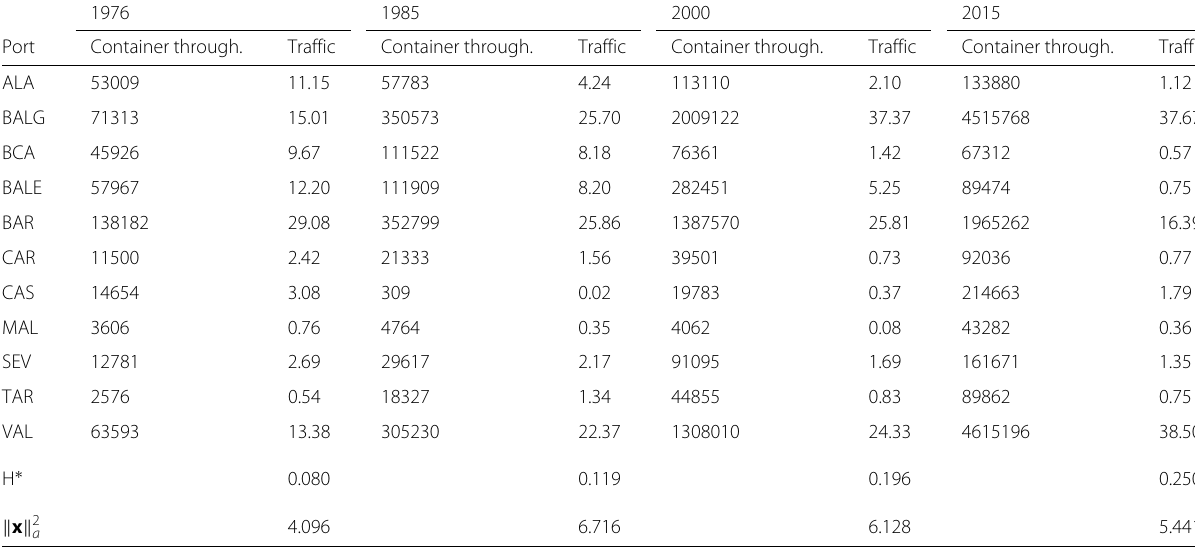
Table 1 Total number of containers (in TEU) and traffic share (in %) for the SpanishMed ports during years 1976, 1985, 2000 and